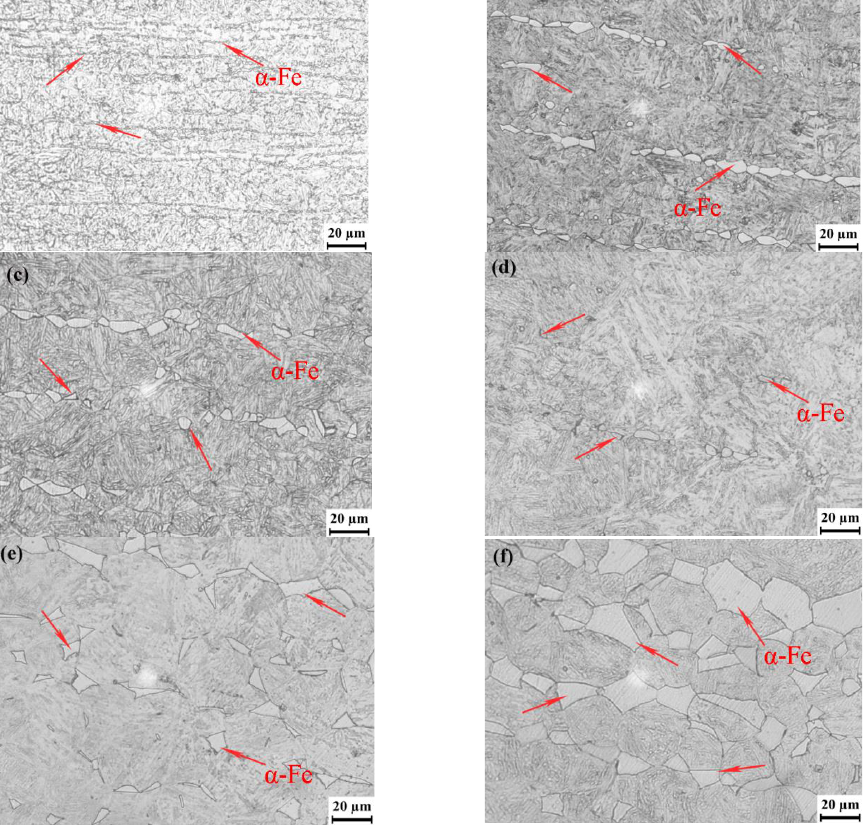
Figure 1. Microstructure of AISI 430 ferritic stainless steel after a solid solution treatment at different temperatures (the red arrow refers to α- Fe). ( a ) Delivered, ( b ) S1080, ( c ) S1120, ( d ) S1160, ( e ) S1200, and ( f ) S1240.